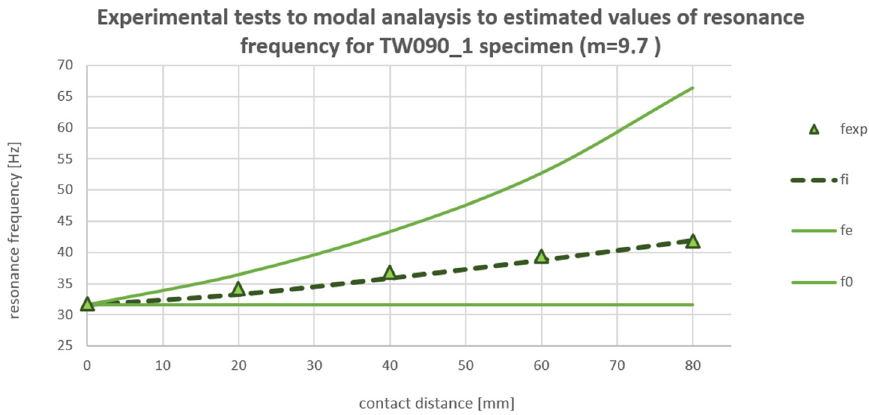
Figure 13. Comparison of experimental tests with modal analysis and estimated values of resonance frequency values for TW090_1 specimen (m = 9.7) .